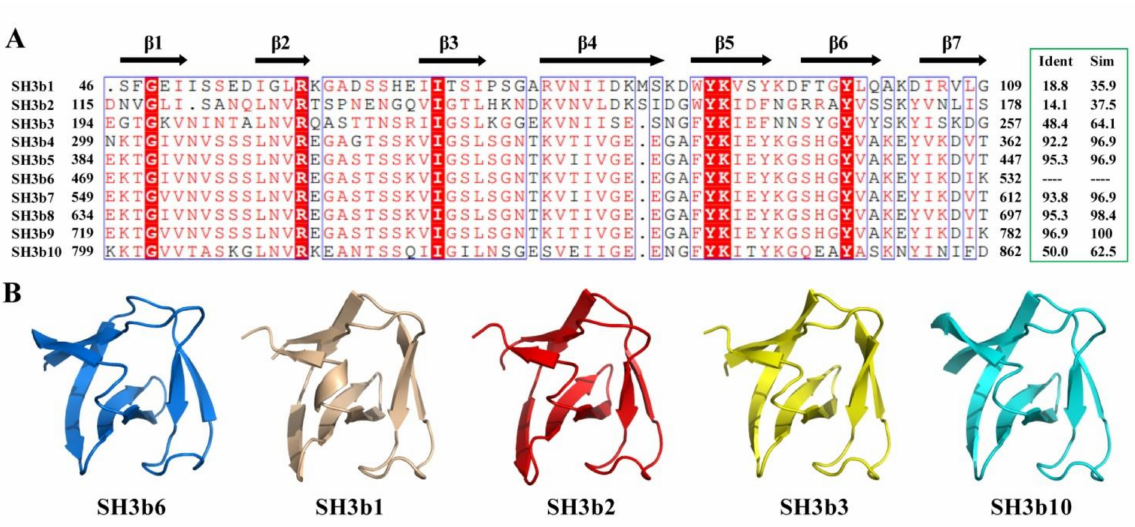
Figure 7. Sequence and structure of CpAcp SH3bs. ( A ) Sequence alignment of 10 SH3bs of CpAcp rendered using ESPript [31] with default settings for similarity calculations. Identical (white letters filled with red color) and similar (red letters with blue box) amino acids are denoted. Secondary structural elements of SH3b6 are indicated above the amino acid sequence. The identity and similarity of SH3b sequences compared to SH3b6 are shown in the green box. ( B ) Structure models of SH3b1/2/3/10 and NMR structure of SH3b6 are shown in the cartoon with individual